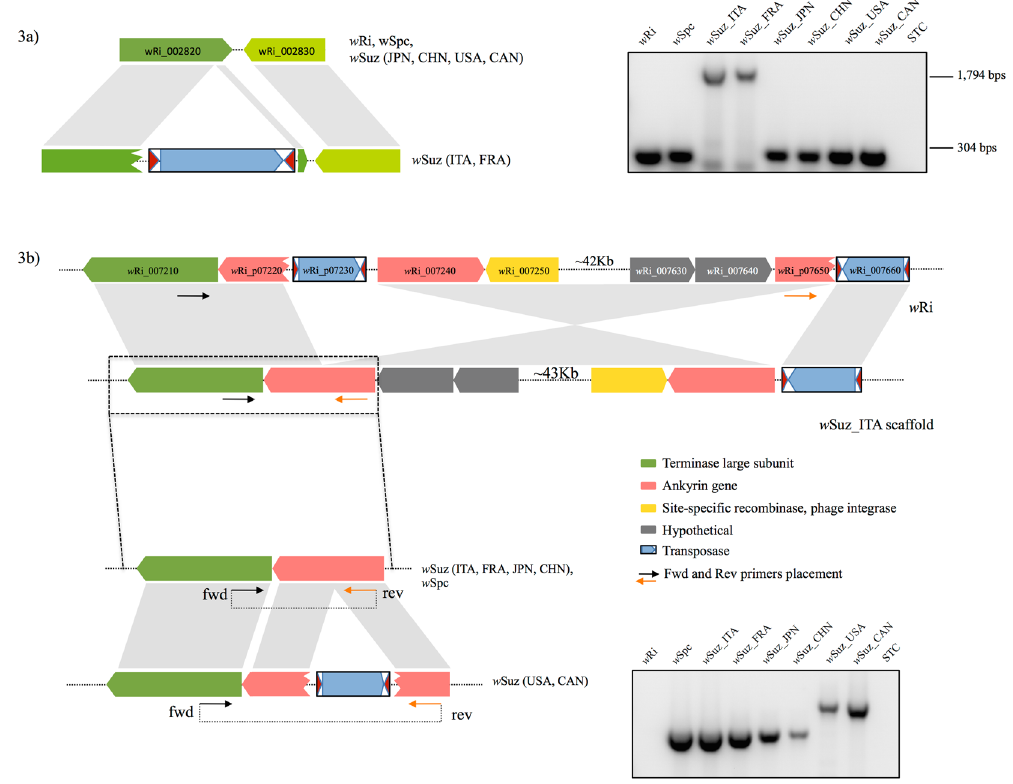
Figure 3. Intra-strain polymorphism of w Suz within different D. suzukii populations. ( a ) w Suz specific IS element (Locus ID- IS32) showing 1,794 bps amplicon size polymorphism in European w Suz ( w Suz_ITA and w Suz_FRA) strains in comparison to other w Suz strains showing amplification of 304 bp size, similar to w Ri and w Spc. ( b ) Genomic rearrangement (GR2) showing size polymorphism in American (USA) and Canadian (CAN) D . suzukii only. Upper panel - schematic diagram of Inverted translocation (IT) shown in w Ri and w Suz genome. The full-length gel pictures are presented in Supplementary Figure